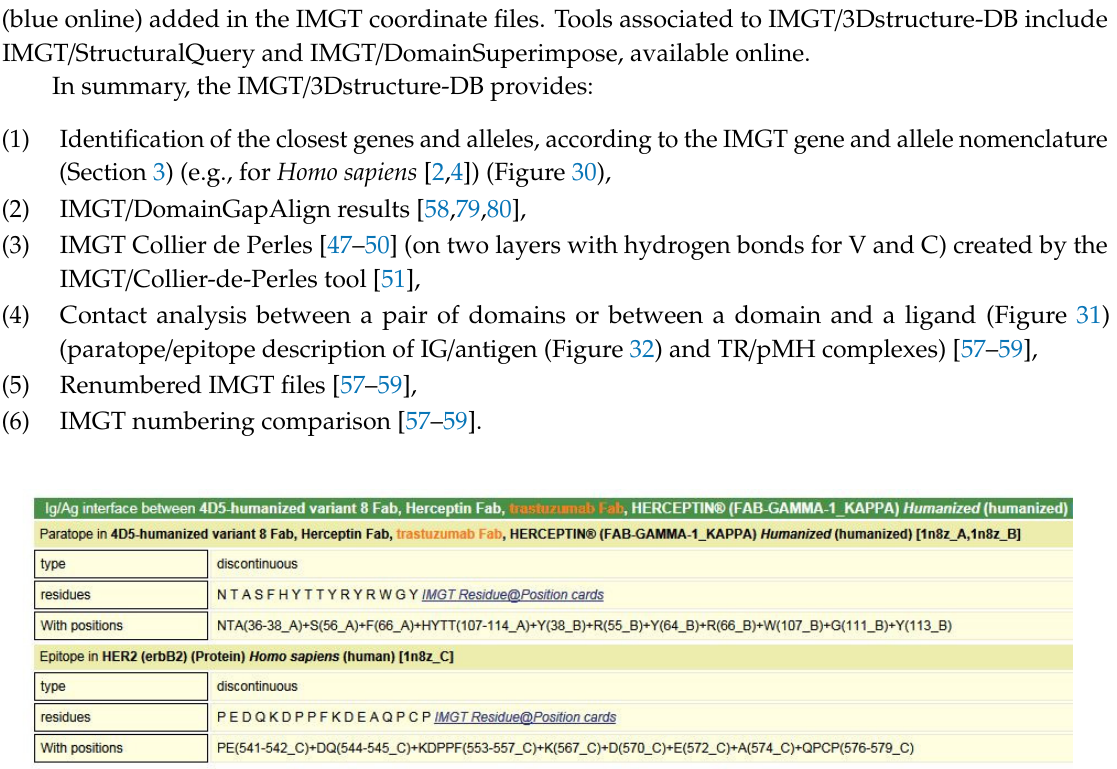
Figure 32. IMGT / 3Dstructure-DB paratope / epitope of trastuzumab / ERBB2 in 1n8z [57–59]. The IMGT paratope, or antigen-binding site, include the part of the VH and VL domains that recognizes (binds to) the antigen (Ag) (epitope or antigenic determinant) [298,299]. In addition to the contacts between amino acids of the CDR1-IMGT, CDR2-IMGT and CDR3-IMGT of the V-KAPPA and VH and the antigen ERBB2 (Figure 31), framework positions which are detected as having relevant contacts with the antigen are included in the paratope. This is the case, here, of the anchor positions of the CDR2-IMGT in V-KAPPA F(66_A) (Figure 31A) and in VH R(55_B) and R(66_B) (Figure 31B). These posiions are classically taken into account in V domain humanization by grafting. (With permission from